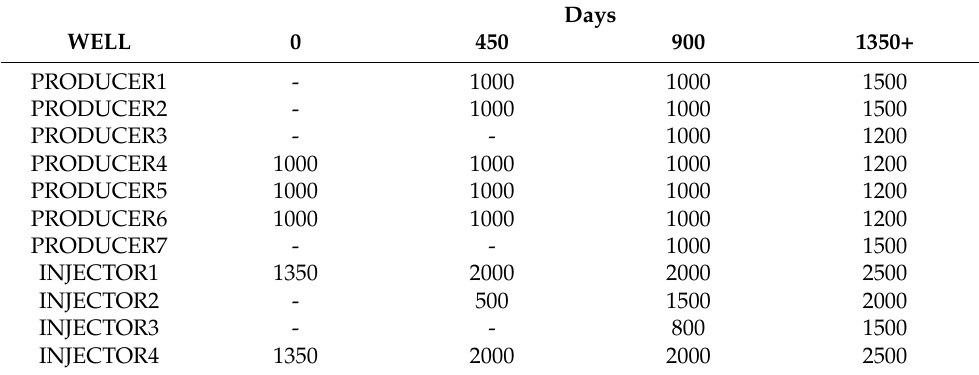
Table 1. Rates over a period of production used for history matching and